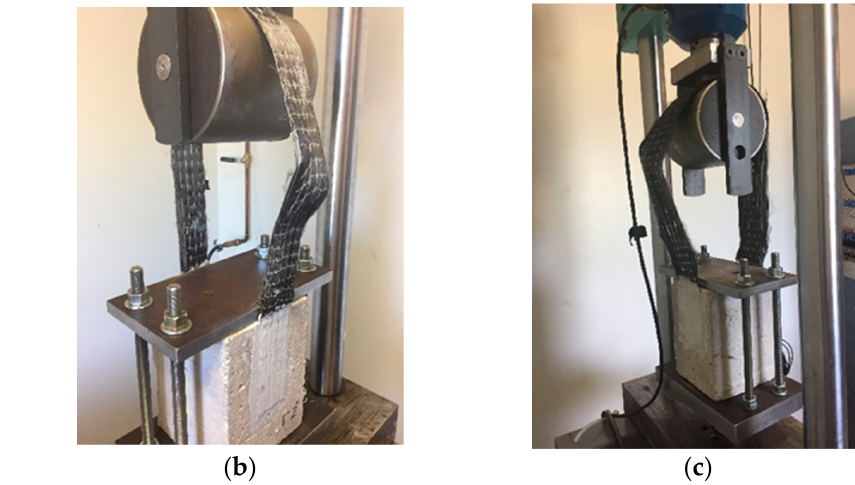
Figure 8. Typical failure mode after 60 days of exposure. ( a ) 25 mm width. ( b ) 50 mm width. ( c ) 75 mm width.